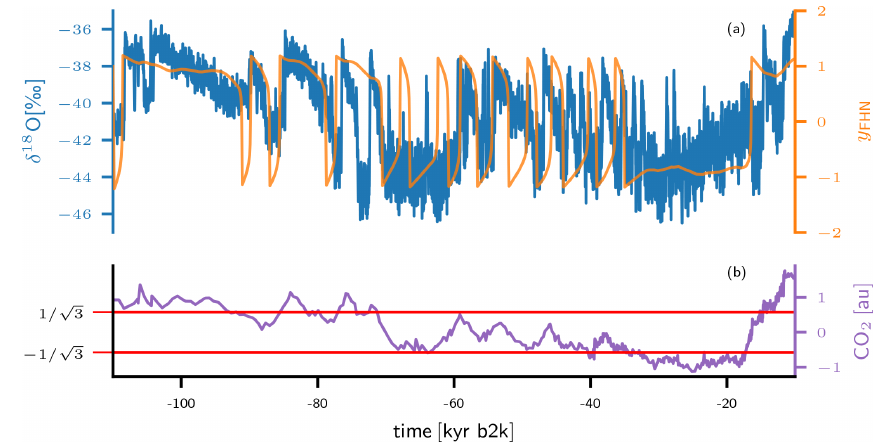
Figure 12. FHN model fit to the NGRIP δ 18 O dataset of 20-year means, as published as a supplement to Seierstad et al. (2014) (see also Rasmussen et al., 2014). Originally, the North Greenland Ice Core Project members (2004) reported a 50-year-mean dataset. (a) The fast component y FHN ( t ) of an FHN model forced with historical CO 2 concentrations (orange), together with the observed δ 18 O record (blue) from the NGRIP ice core (Seierstad et al., 2014). (b) Rescaled atmospheric CO 2 concentrations from Antarctic ice cores in arbitrary units (au) (Bereiter et al., 2015a); the horizontal red lines indicate the lower and upper bounds, y min = the free-oscillation